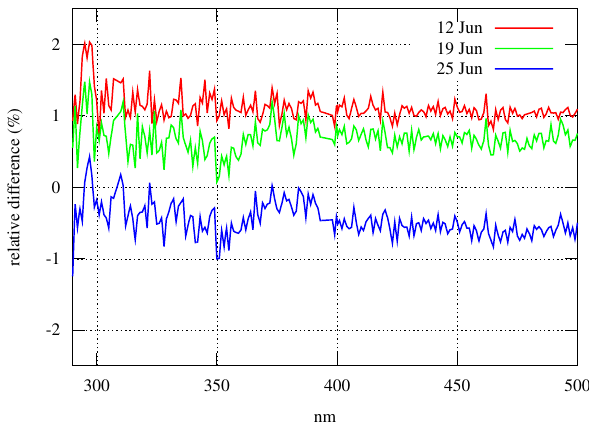
Fig. 1. Percentage variations of the spectroradiometer spec- tral responsivity relative to the first calibration in the campaign (4 June 2010). Every calibration curve is obtained as an average of the responsivities measured with three lamps.